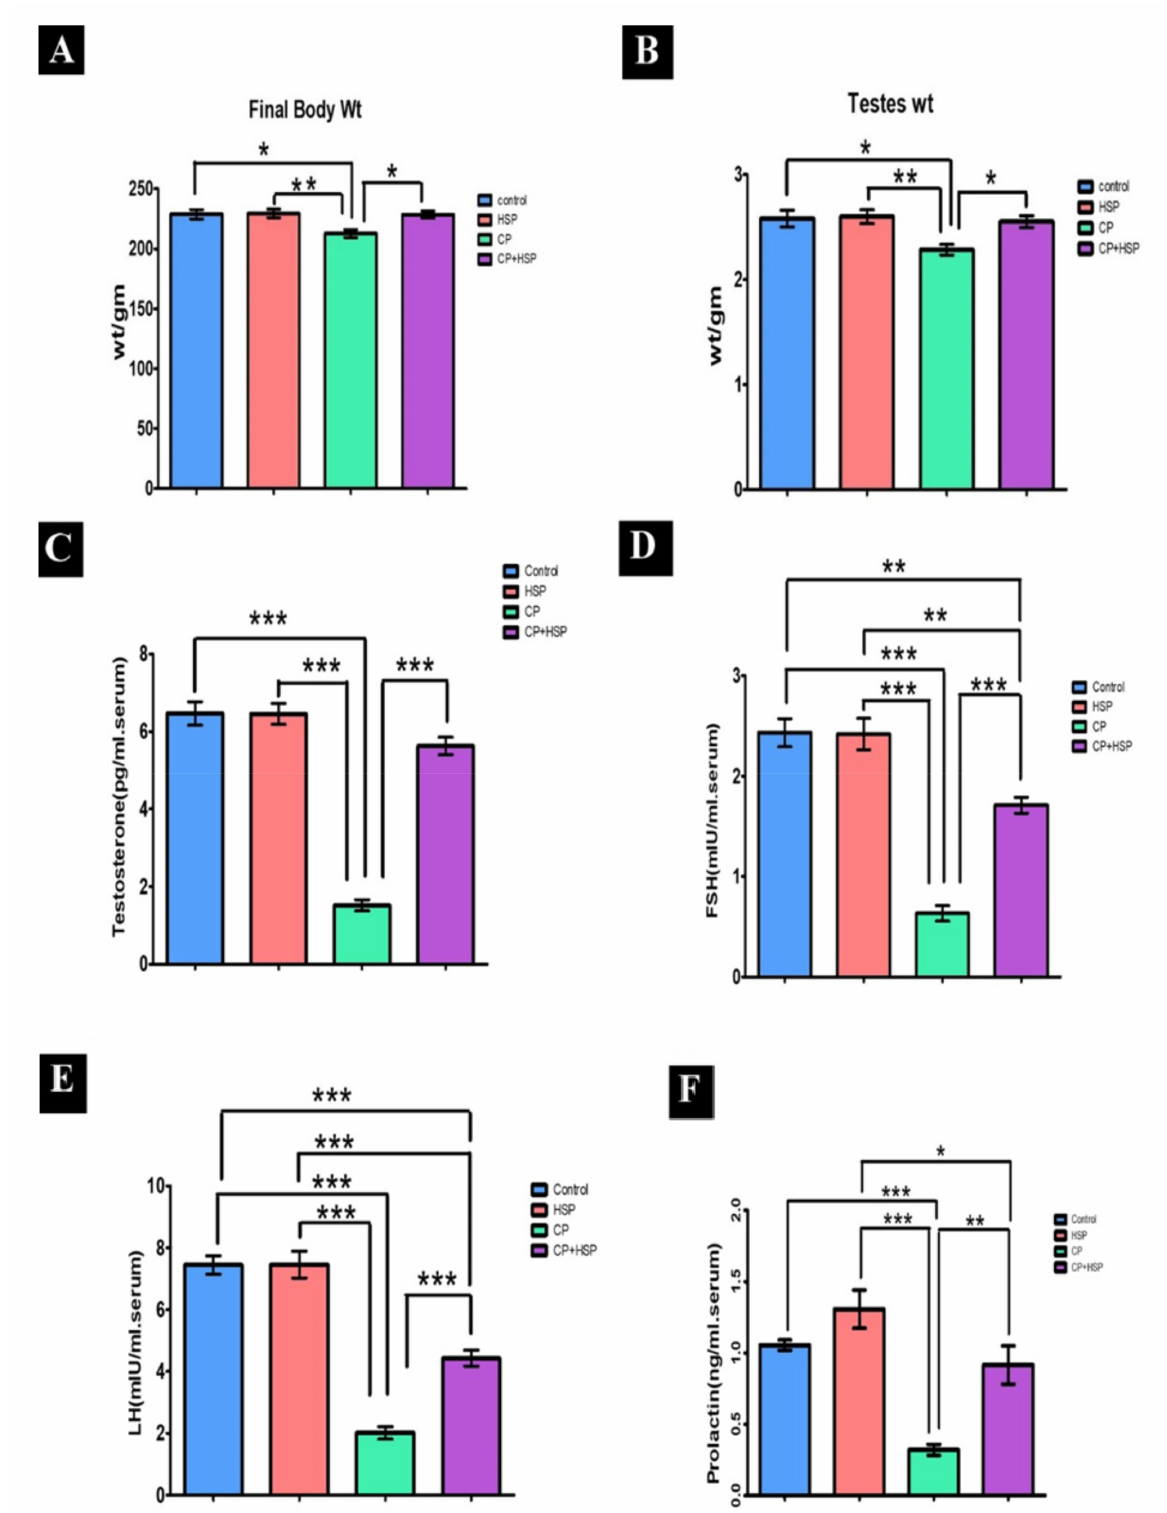
Figure 1. Effect on the final body, testicular weights and serum hormones ( A – F ). ( A ) Body weight (g), and ( B ) weight (g), ( C ) serum testosterone level (pg/mL), ( D ) serum FSH (mIU/mL) level, ( E ) serum LH (mIU/mL) level, and ( F ). serum prolactin (ng/mL) level. Data are expressed as means ± SEM. N = 8. *, **, *** indicate significant difference ( p <